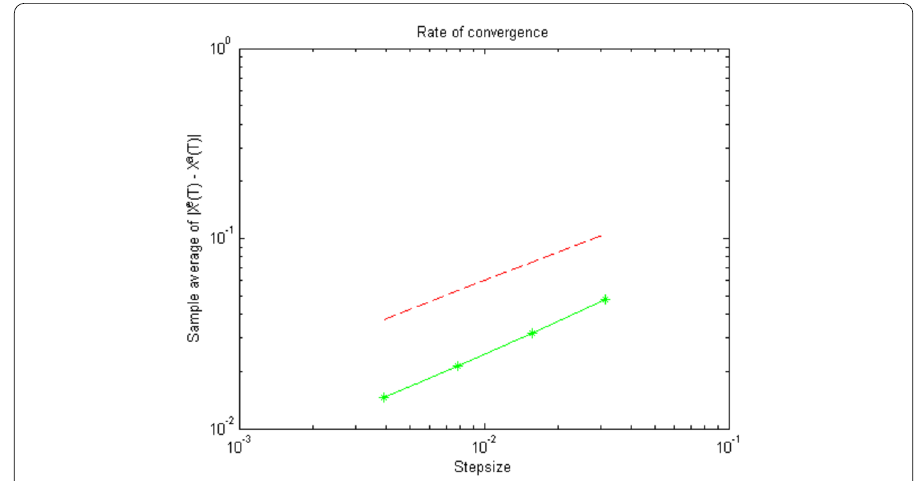
Figure 1 The rate of strong convergence for Example 5.1 with T = 1. The logarithm of (cid:14) T is denoted by the green line with asterisk which is parallel with the dashed red line by slope 1